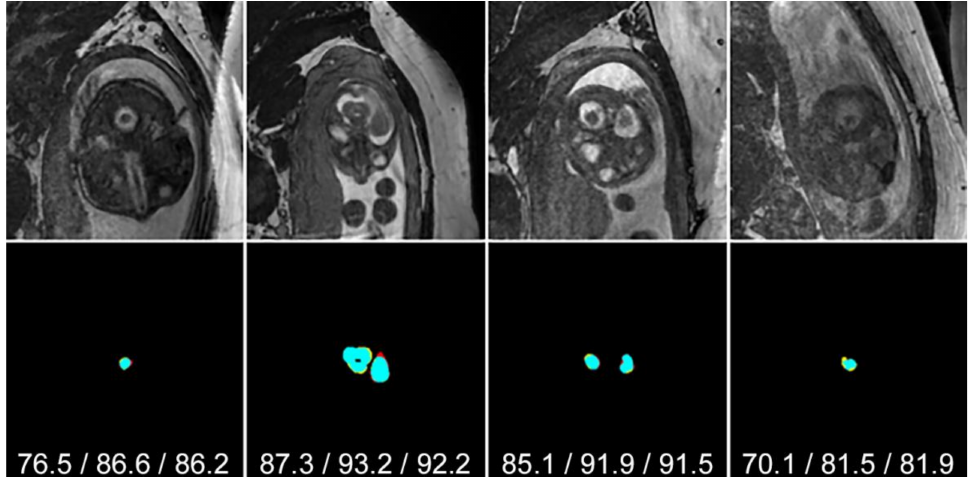
Figure 4. Typical examples of P AVG segmentation results from top and bottom slices. Black, cyan, red and yellow represent TN , TP , FP and FN , respectively. Jaccard/Dice/Sensitivity scores are shown under each